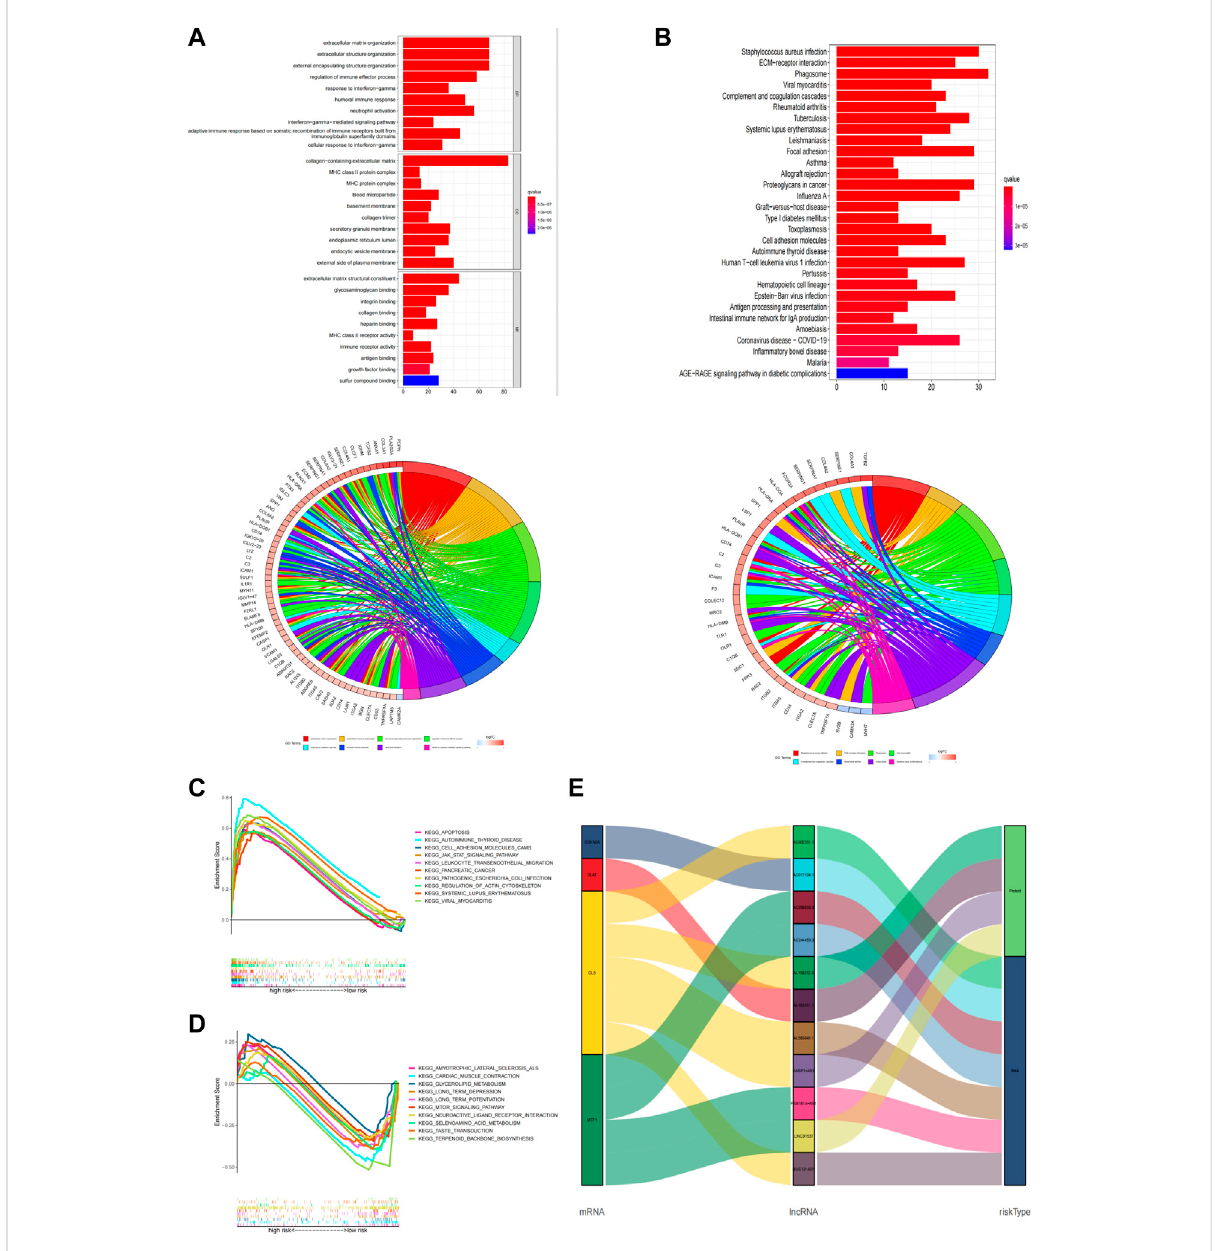
FIGURE 7 Functional analysis. (A,B) Top10 classesofGO enrichmenttermsinbiologicalprocess (B) , cellularcomponent (C) ,and molecular function(MF) based on 11 cuproptosis-related lncRNAs. (C,D) Top 30 classes of KEGG enrichment terms. (E) Sankey